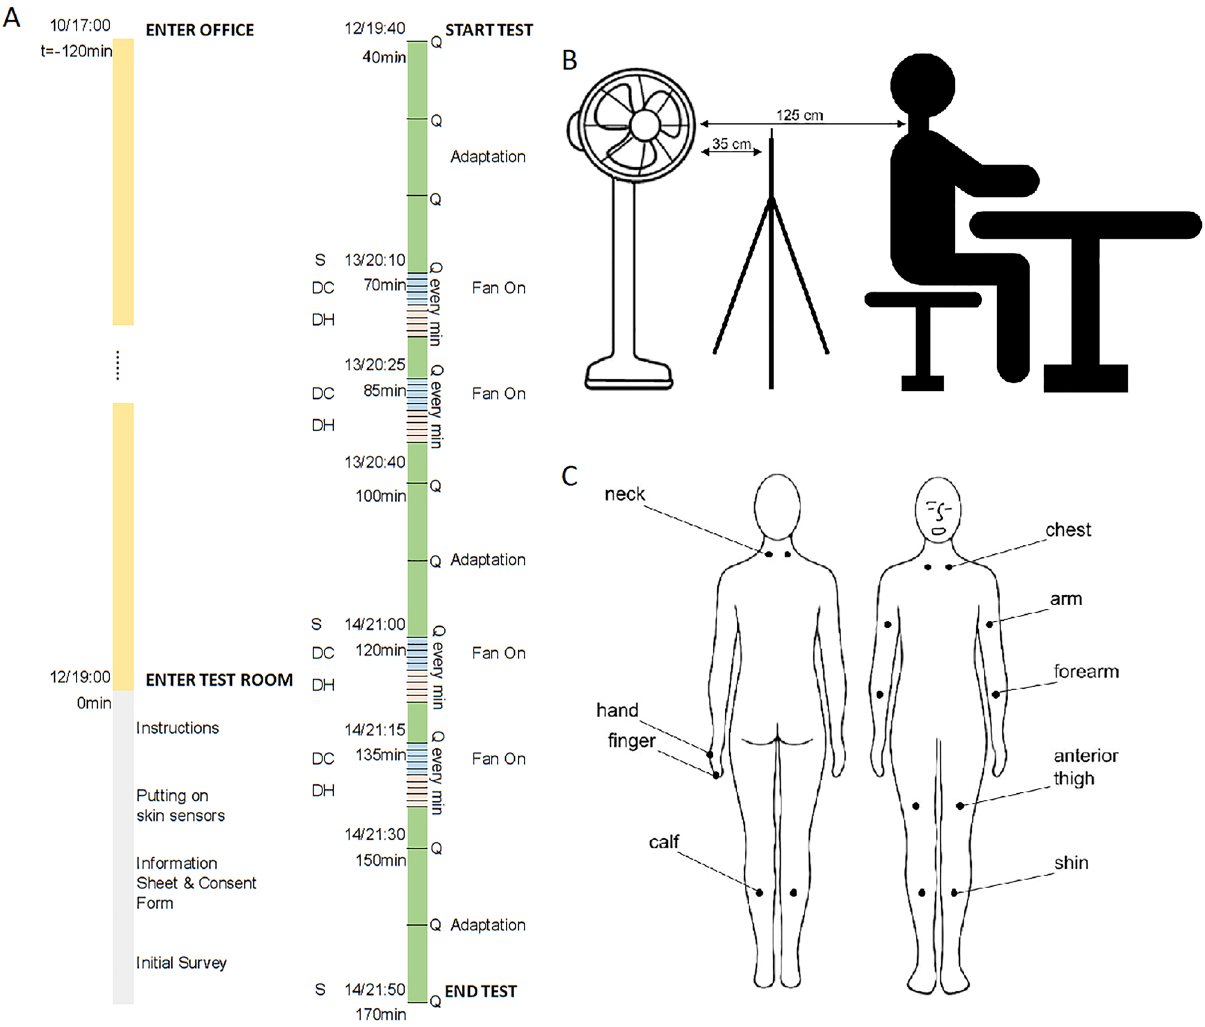
Figure 2. Experimental procedure ( A ), setup ( B ), and overview of the 16 skin measurement locations ( C ). “Q” indicates the times the questionnaires are filled out. “DC” and “DH” indicate the four sequences of partial-body active cooling and passive warming respectively. “S” indicates the times when steady-state thermal conditions are